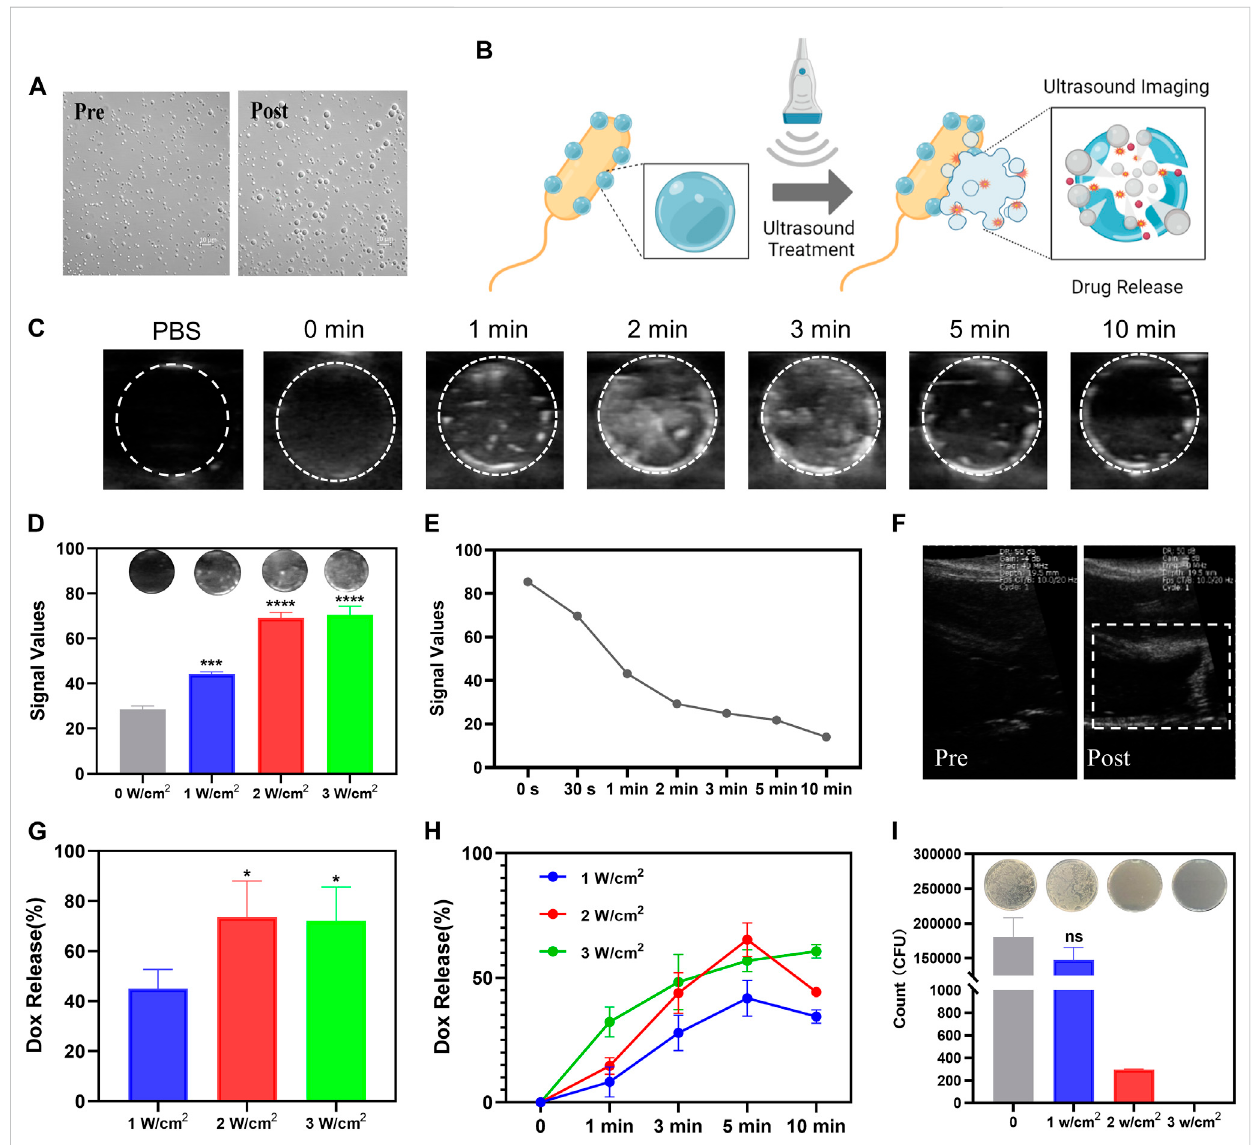
FIGURE 4 The controlled release of drugs under the guidance of ultrasound imaging of SonoBacteriaBot. (A) The transition from nanodroplets to microbubbles of PFP-PLGA. (B) The schematic diagram of ultrasound images and drug release of SonoBacteriaBot (created with